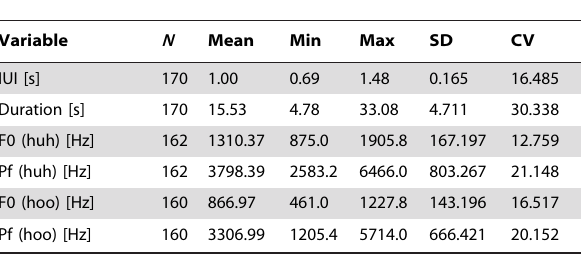
Table 1. Descriptive statistics of acoustic parameters.